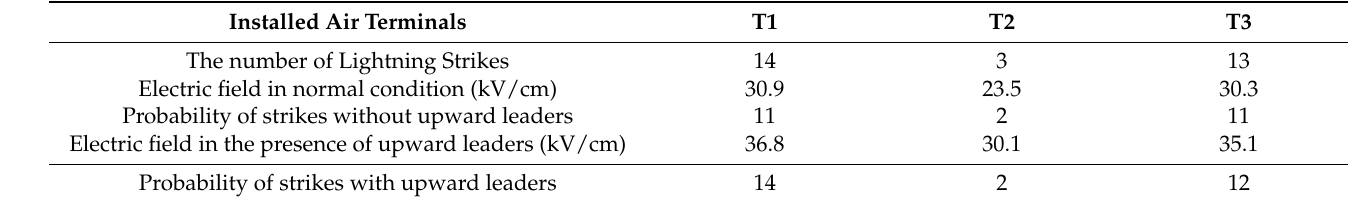
Table 2. Probability of lightning strikes on gable